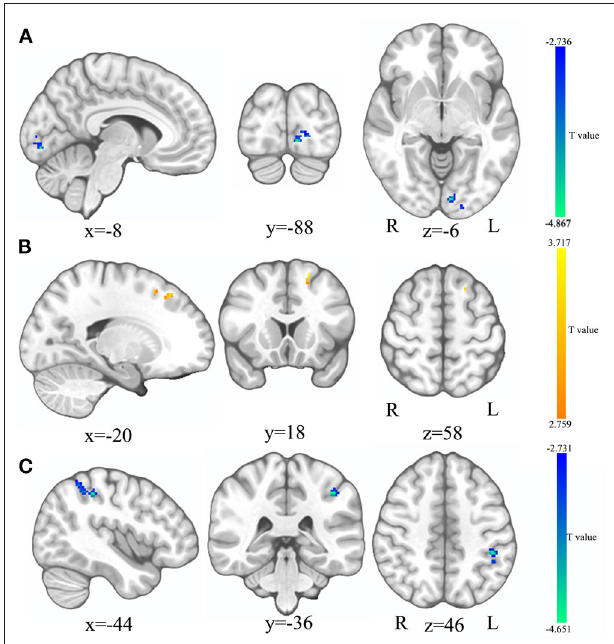
FIGURE 2 | The comparison in ReHo and fALFF between HC and SG0W. (A) The brain region where the ReHo values of SG0W decreased; (B) The brain region where the ReHo values of SG0W increased; (C) The brain region where the fALFF values of SG0W decreased; SG0W, post-stroke depressive patients before treatment; HC, healthy controls; ReHo, regional homogeneity; fALFF, fractional amplitude of low-frequency fluctuation; L, left; R,